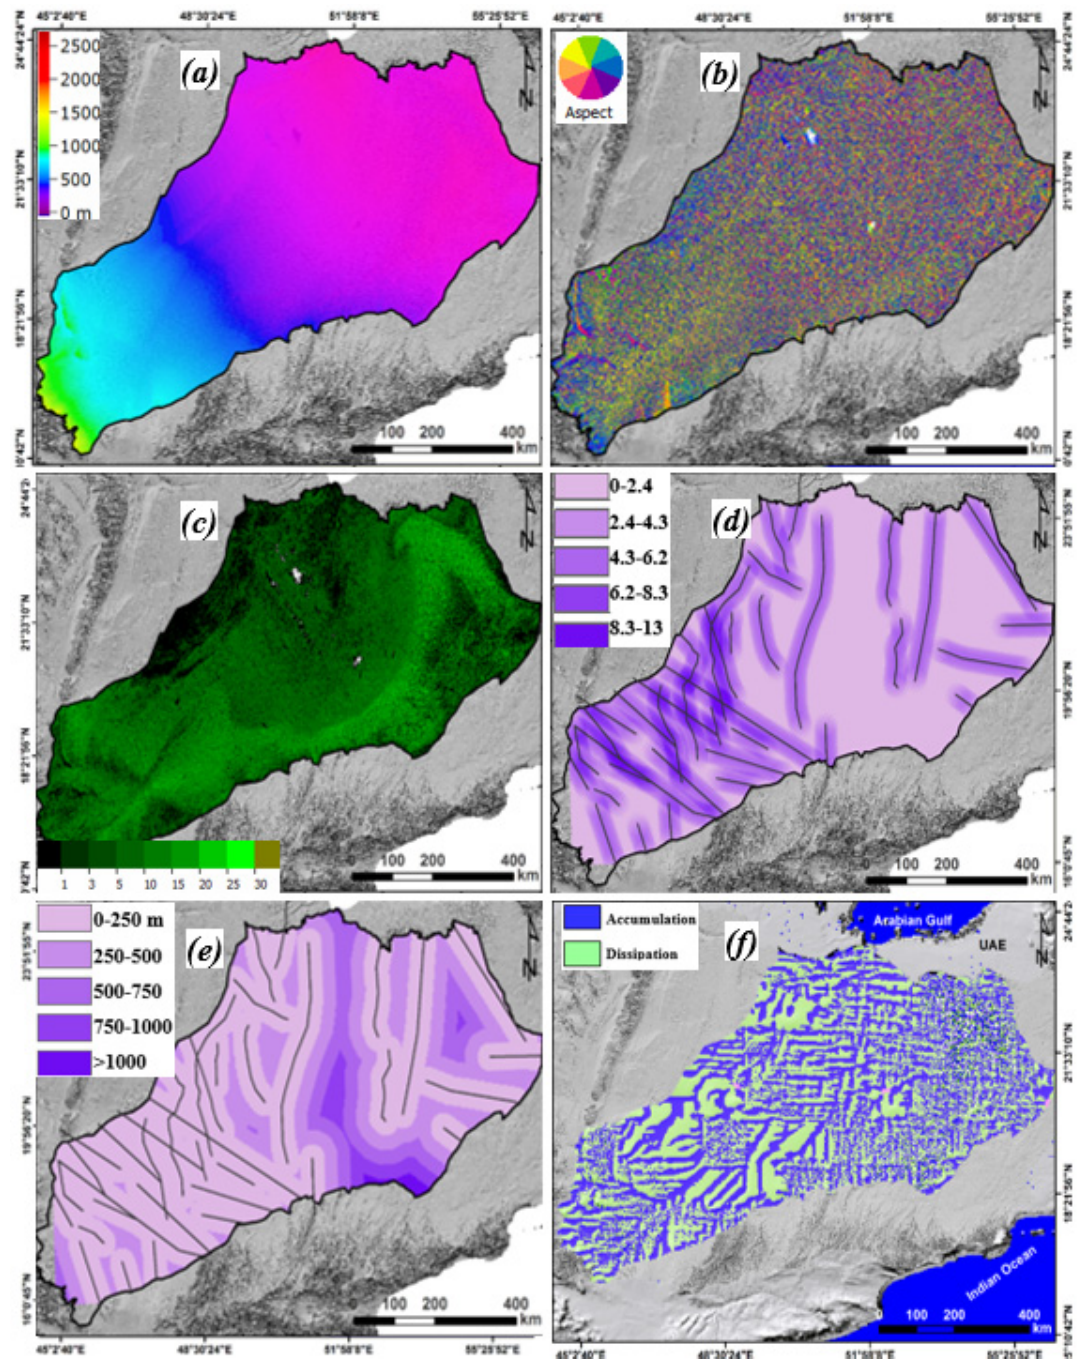
Figure 6. Maps of altitude ( a ), aspect ( b ), slope ( c ) fault density ( d ), distance from faults ( e ), and zones of flow accumulation for the